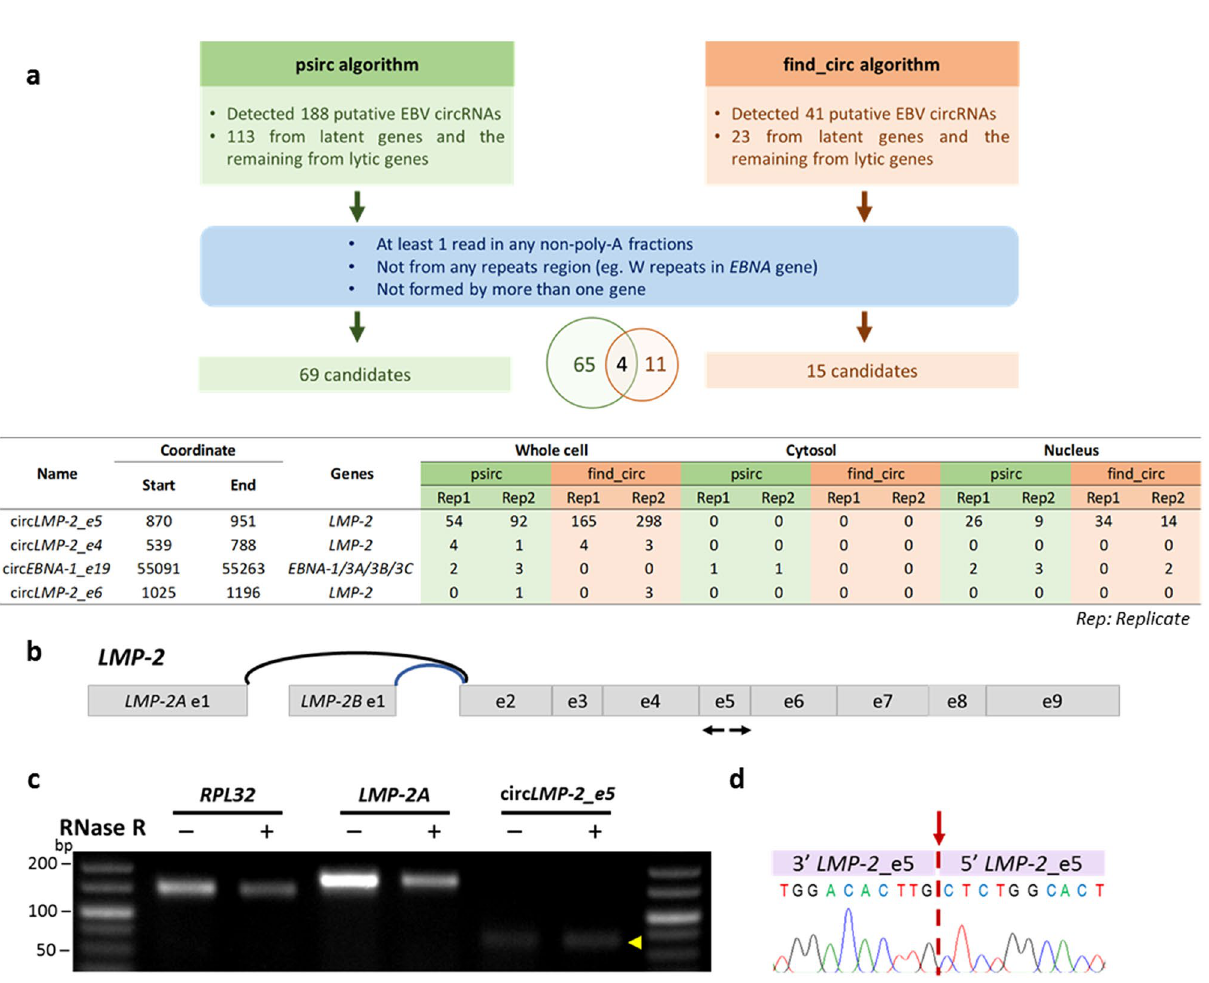
Figure 1. Screening and validation of putative EBV circRNAs in GM12878 cell line. ( a ) Schematic summary demonstrating the strategy for identification and filtering of putative EBV circRNAs from RNA-seq datasets. The table shows the location, exons involved and read counts for overlapping putative EBV circRNAs identified from non-poly-A subcellular fractions by both algorithms, psirc and find_circ. ( b ) Schematic representation of divergent primer pairs used for the detection of BSJ of circ LMP-2 _e5 identified by the two algorithms. Black arrows indicate the position of divergent primer pairs used. ( c ) RNase R resistance of circ LMP-2 _e5 in the GM12878 cell line, as indicated by the yellow arrowhead. The full-length gel image is shown in Fig. S6. ( d ) The expected PCR product was Sanger sequenced and the BSJ of circ LMP-2 _ e5 was confirmed, as indicated by the red downward